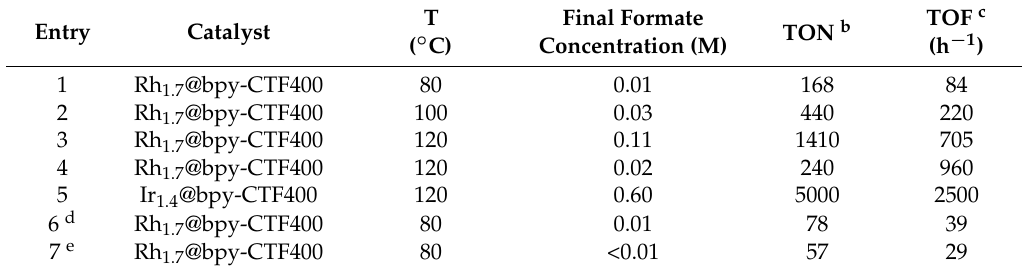
Table 1. Catalytic Performances of Rh 1.7 @bpy-CTF400 in comparison with Ir 1.4 @bpy-CTF400